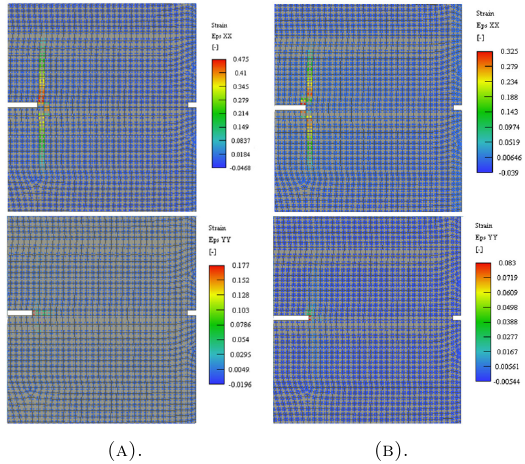
Figure 19. CT test simulation result of normal strains ε xx and ε yy at crosshead displacement of (A) 4 . 0 mm and (B) 5 . 0 mm with the pre-stress level of 3 . 3 MPa and critical load-grain angle of (A) θ c = 0 . 4° and (B) θ c = 1 .